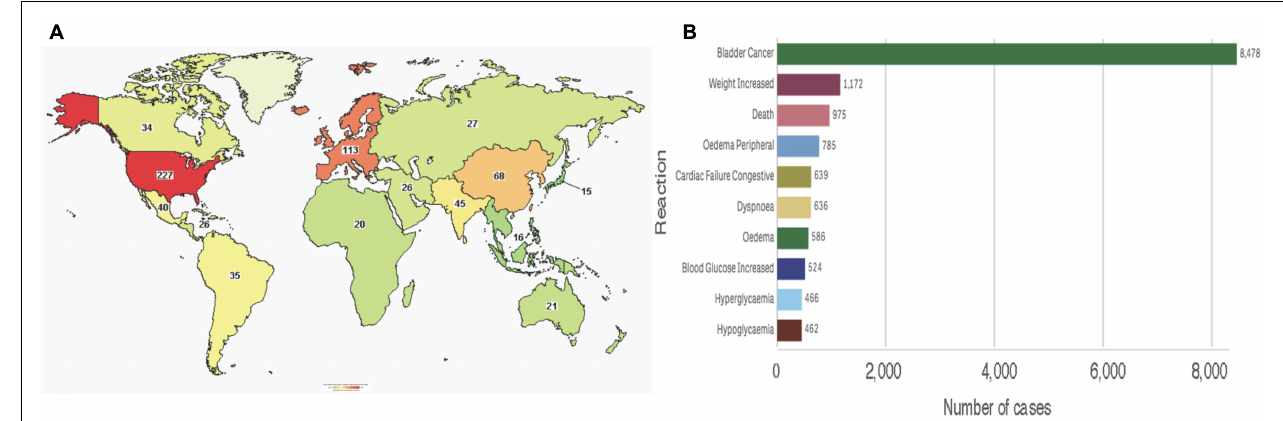
FIGURE 5 | Pioglitazone in patients (A) Map showing number of pioglitazone trials that used subjects from each country (source: www.clinicaltrials.org). (B) Total reported reactions in the FDA adverse events reporting system for ACTOS from 1999 to December 31, 2018 (source: